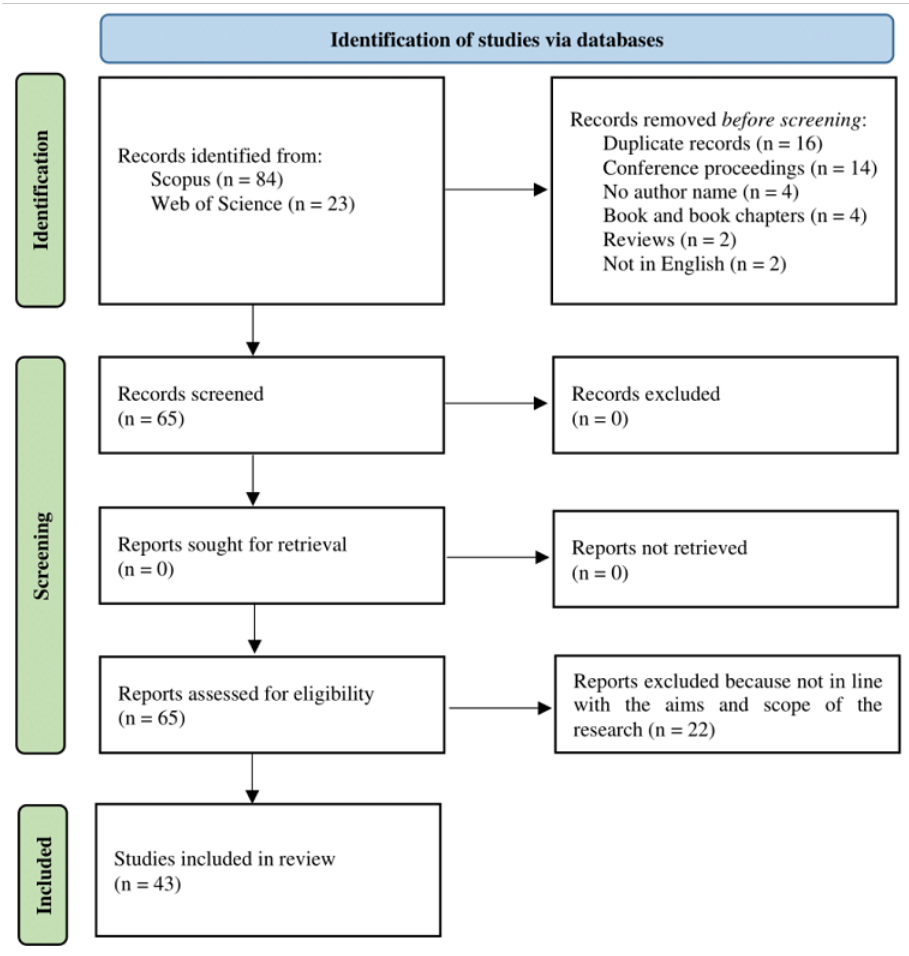
Figure 1. The PRISMA model. Source: personal elaboration by the authors on Page et al. [40]. Table 1 summarises the 43 selected contributions, including their year of publication and journal titles. Table 1. The list of the 43 selected contributions per author(s), year, and journal. Source: personal elaboration by the authors.